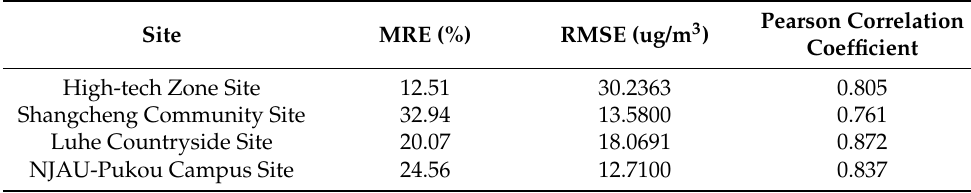
Table 6. Evaluation results of the four monitoring sites for SVR